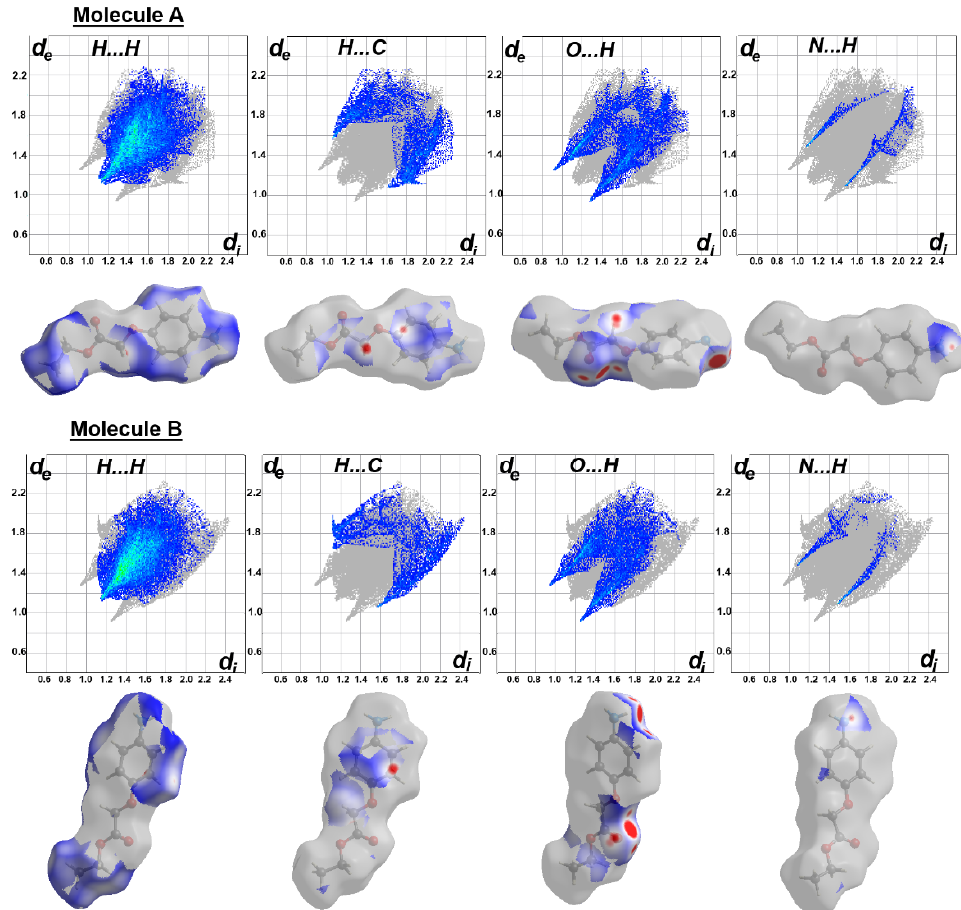
Figure 6. Decomposed fingerprint plots and d norm maps for 4 . Table 3. Contact distances of the most important intermolecular interactions. Contact Distance Contact